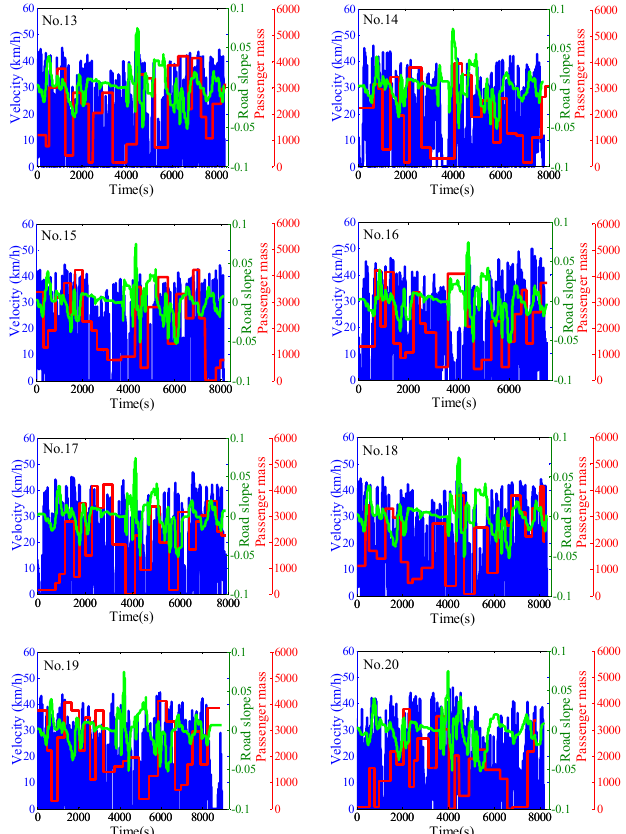
Figure 8. The combined driving cycles from No. 13 to No. 20.